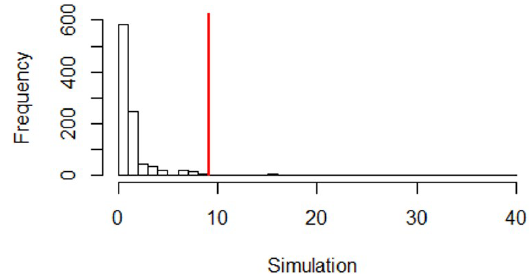
Figure D3. RMS simulation ratios in relation to the observed ratio (red) at 5–10cm depth.